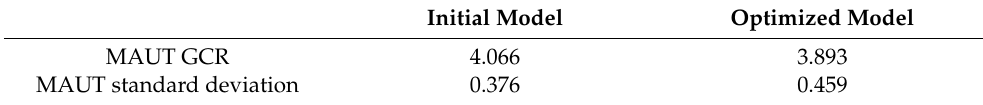
Table 4. Global Competitiveness Rate by initial and optimized